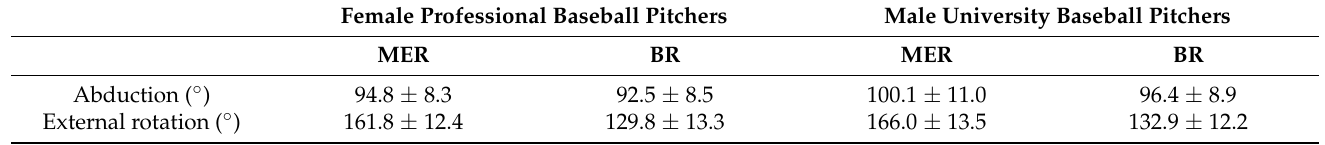
Table 2. Shoulder joint angle.